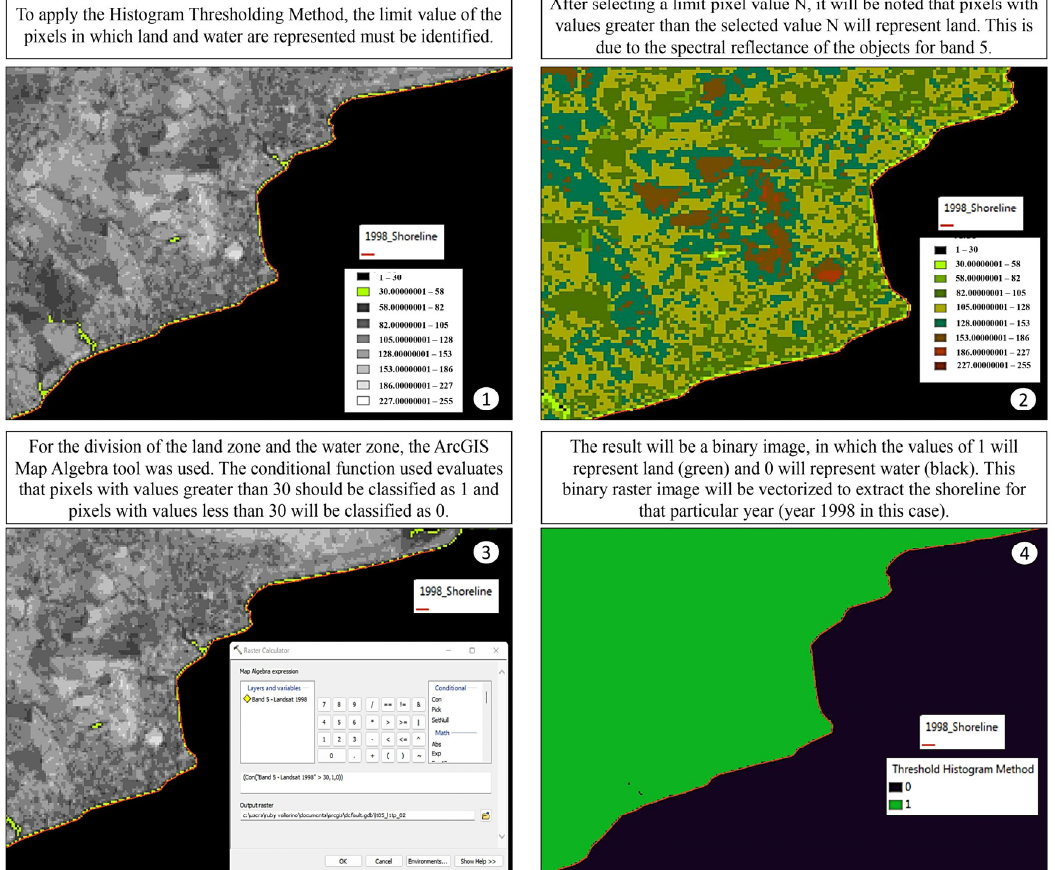
Figure 3. Histogram Thresholding Method